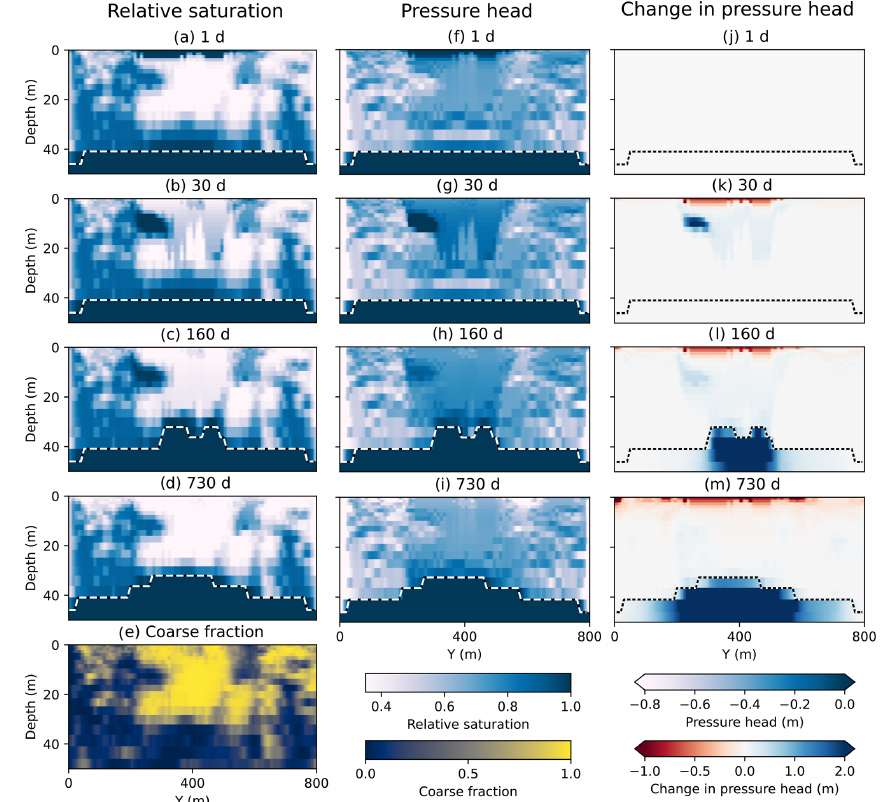
Figure 5. Vertical cross sections of relative saturation (a–d) , coarse fraction (e) , pressure head (f–i) and the change in pressure head since day 0 (j–m) for a single simulation for 2 years (730d) following a single 0.8m inundation event. Transient increases in saturation within coarse-grained sediments can be observed at 30d and within fine-grained sediments at 30 and 60d. The dashed line shows the position of the water table, with obvious water table mounding at 160 and 730d. Only the upper 50m of the model domain is shown.